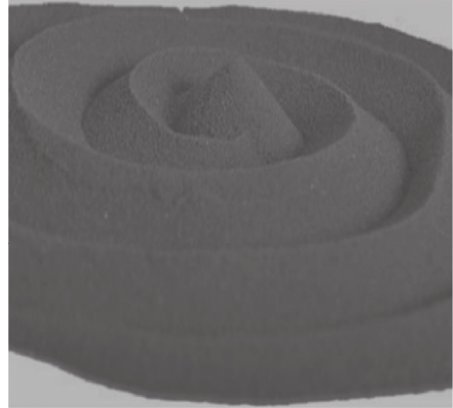
Figure 3: Gravel used for the volume